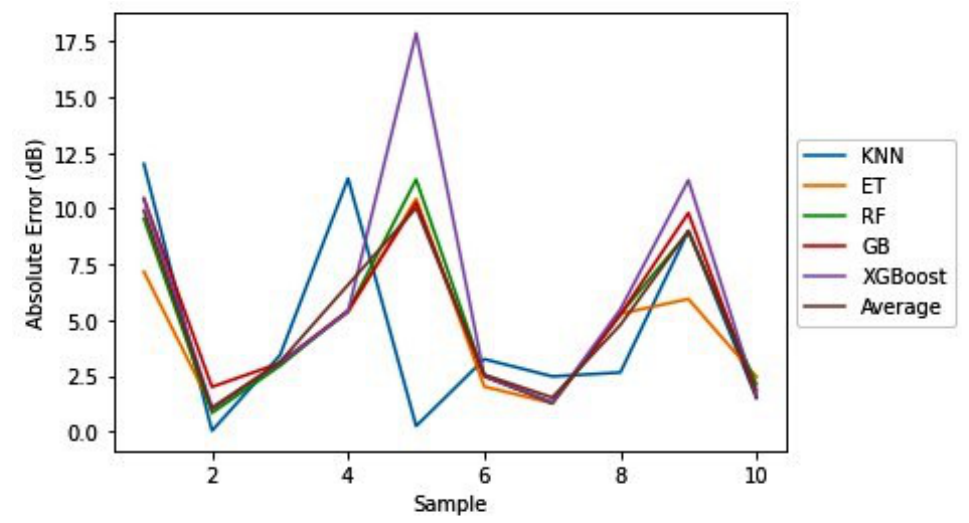
Figure 3. Absolute error of sample points in the validation